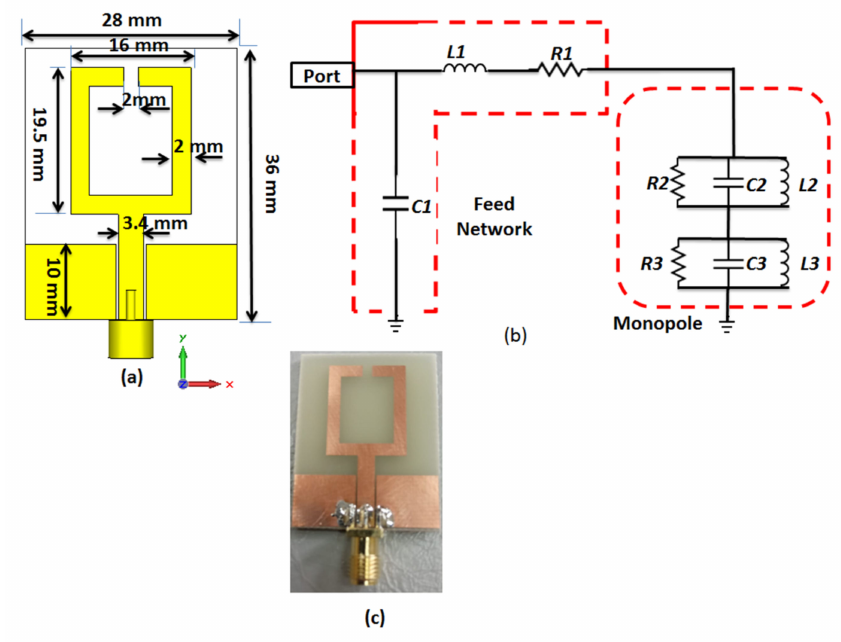
Figure 3. CPW monopole antenna structure: ( a ) 2-D configuration; ( b ) equivalent circuit with the simplified model (where R1 = 3.097 Ω , R2 = 87.13 Ω , R3 = 76.24 Ω , L1 = 1.73 nH, L2 = 1.486 nH,